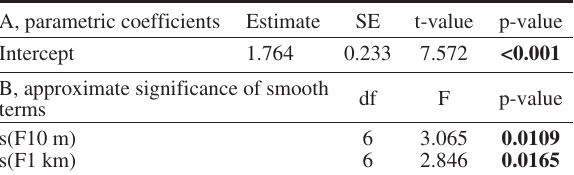
explained=47.5%. N=74.